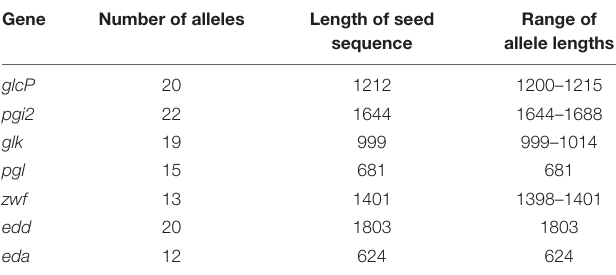
TABLE 2 | Allelic diversity of components of the glc locus among 113 ED-positive Campylobacter isolates.